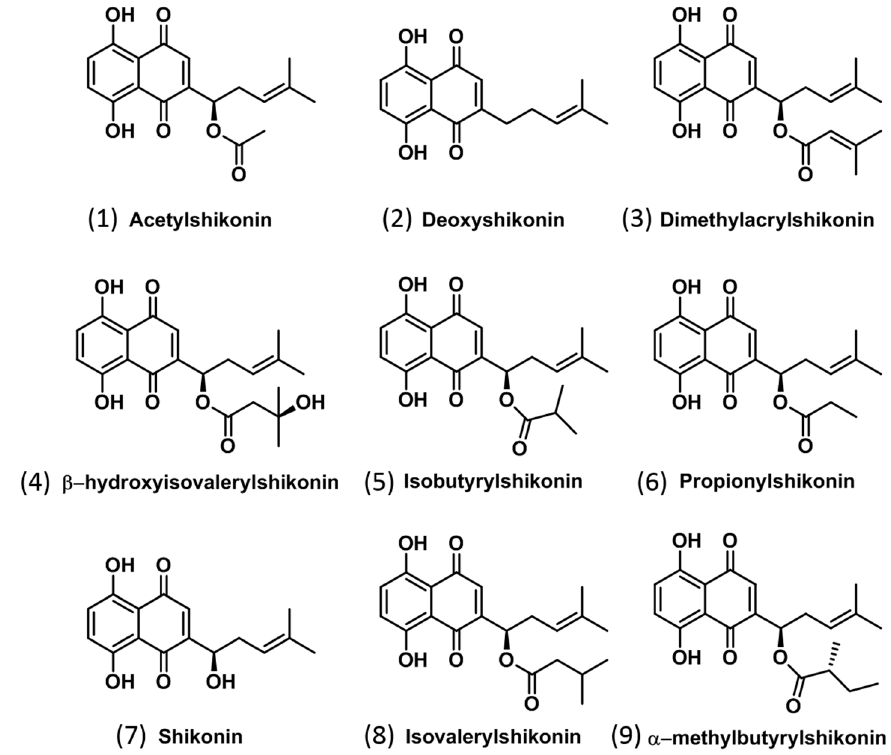
Figure 1. Structures of shikonins identified in Echium plantagineum and E. vulgare (Table 1). Isolvaleryshikonin and α -methylbutyrylshikonin are referred to as compound 8 and compound 9 , respectively.